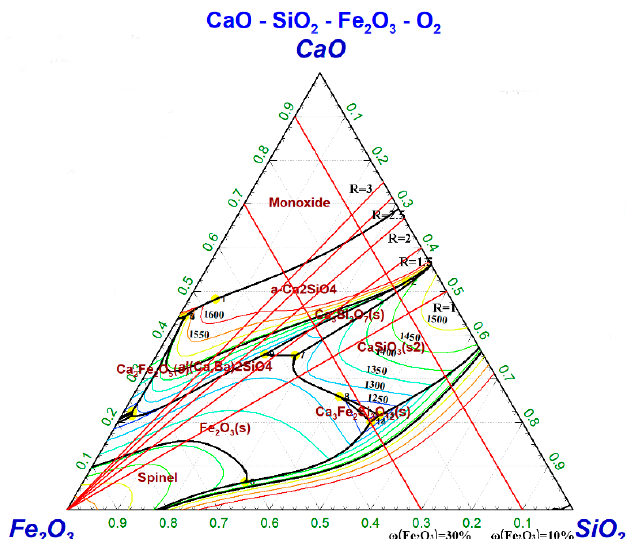
Figure 5. Ternary phase diagram of CaO–SiO 2 –Fe 2 O 3 .